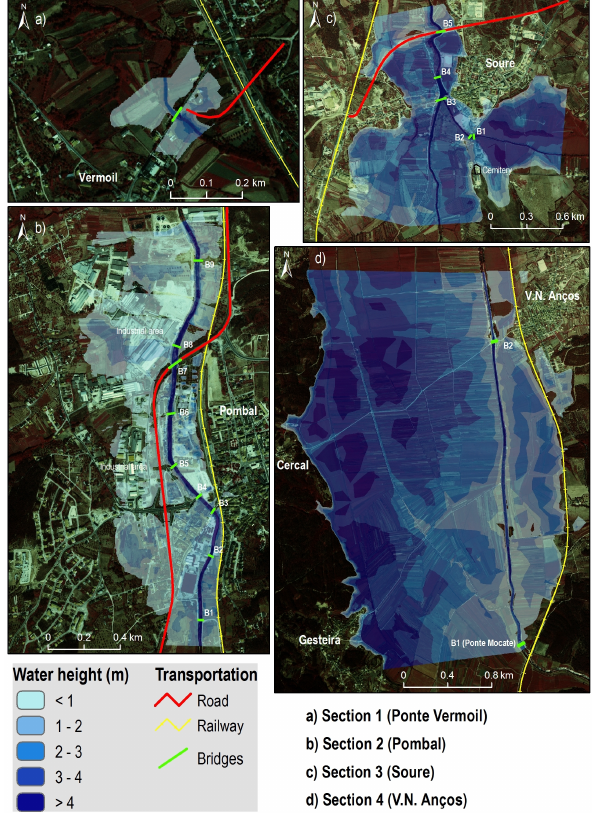
Fig. 8. Flood-prone areas and water height in the modelled